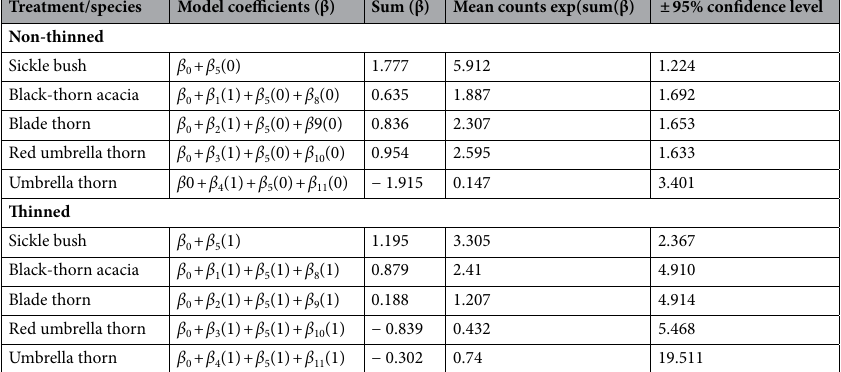
Table 3. Expected number of tree/shrubs counted per subplot (area = 113.1 m 2 ) in the thinned and non- thinned treatment areas estimated from the generalized linear mixed-effects model (GLMM) model coefficients.